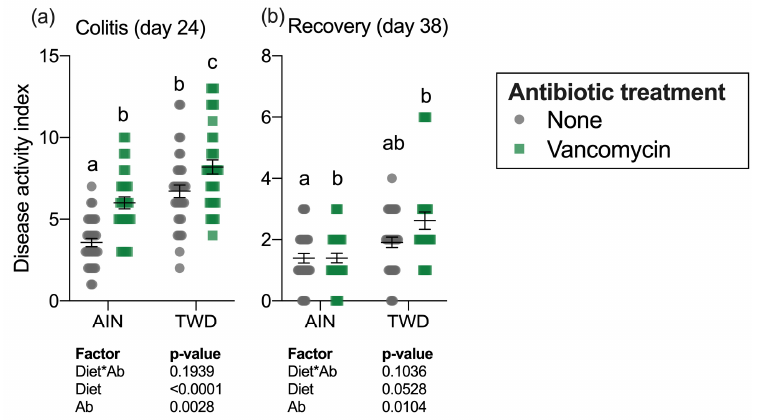
Figure 2. Disease activity index during active colitis (day 24) ( a ) and recovery from gut injury (day 38) ( b ). Values shown are the individual measurements for each animal with the mean ± standard error ( n = 30 to 36). Main effects of experimental factors diet, antibiotic treatment and diet*antibiotic interaction are shown as determined by generalized linear mixed model, and different letters indicate experimental groups are significantly different ( p < 0.05) as determined by the Tukey HSD post-hoc